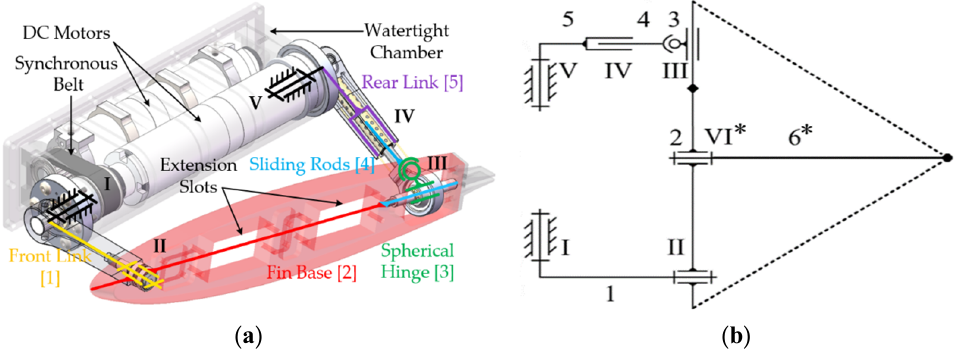
Figure 2. Dual-DOF bionic propelling mechanism. ( a ) Structural assembly of the spatial parallel mechanism; ( b ) Planar scheme of the mechanism.